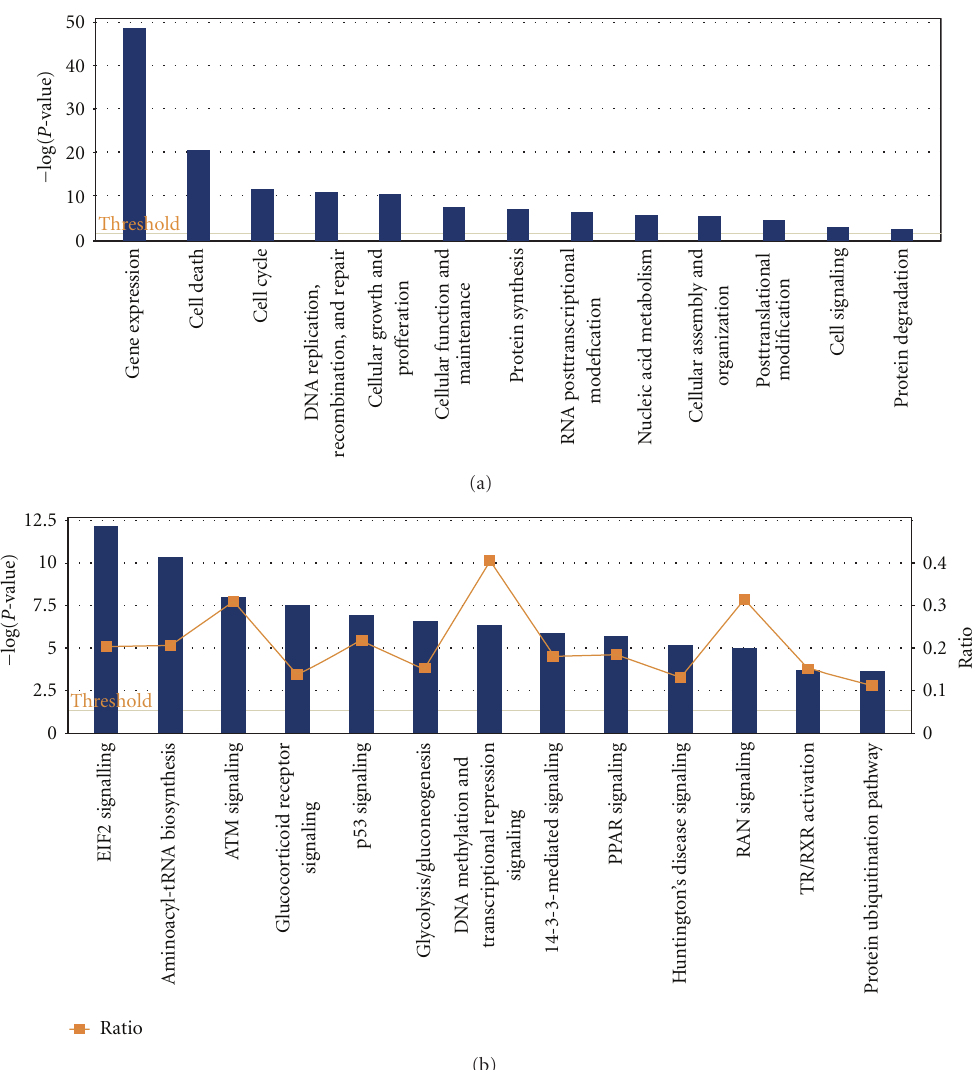
Figure 7: Molecular functions and canonical pathways regulated by SUMOylation. Ingenuity (IPA) analysis of proteins reported to be SUMO-modified in the PhosphoSitePlus (http://www.phosphosite.org/) and 3 recent MS studies [39, 75, 76]. (a) The top molecular functions are indicated. A dominant link to gene expression has been found. All functions are superior to the threshold (yellow line). (b) The top canonical pathways are indicated. All shown pathways are superior to the threshold. The Canonical Pathways that are involved in this analysis are displayed along the x -axis. The right y -axis displays the ratio up to 0.6. The ratio is calculated as follows: number of genes in a given pathway that meet cut-o ff criteria, divided by total number of genes that make up that pathway. Therefore y -axis displays the results importance. For the ratio, taller bars have more genes associated with the Canonical Pathway than shorter bars. The graph displaying the various pathways is presented from largest ratio to smallest